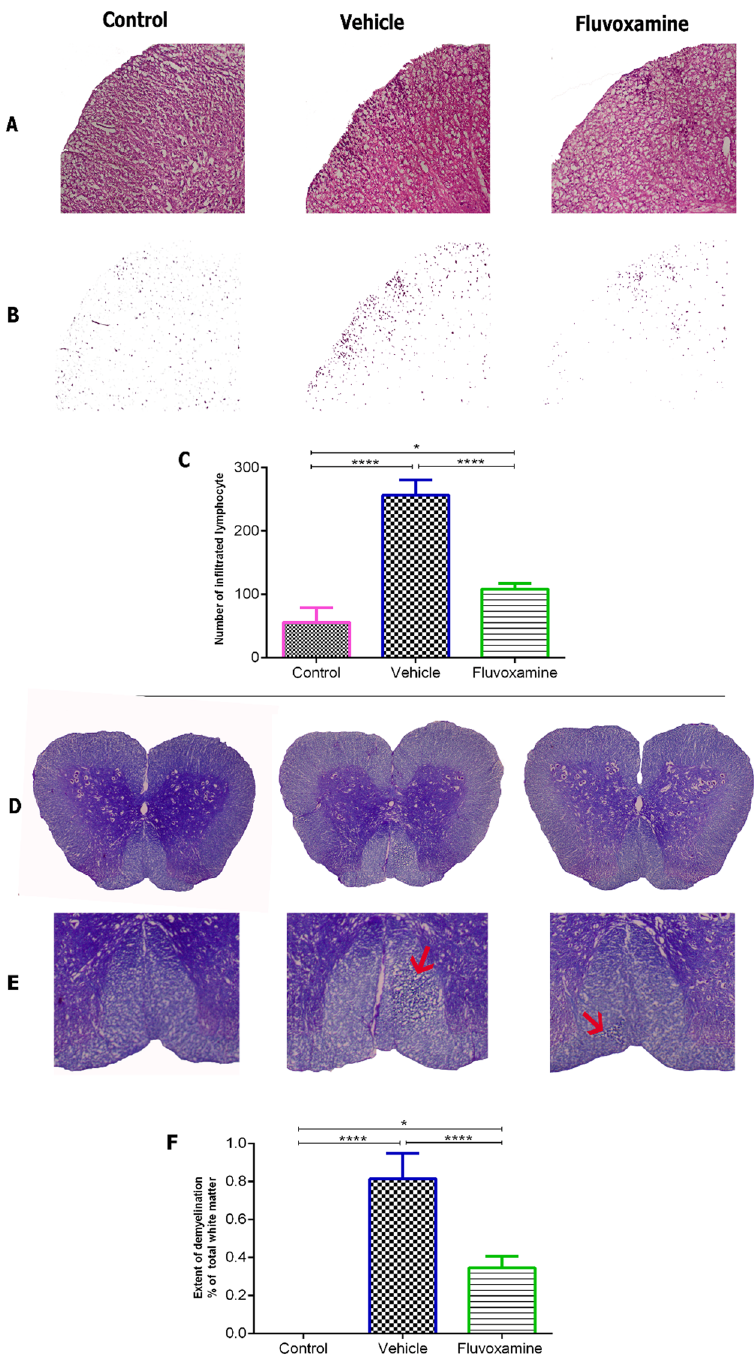
Figure 8. Fluvoxamine treatment enhanced histological outcomes in spinal cords of EAE rats. In order to detect inflammatory infiltration and demyelination, serial sections were analyzed by Hematoxylin and Eosin ( A – C ) and Luxol Fast Blue staining ( D – F ). ( A ) Inflammatory infiltration with extensive perivascular cuffing was limited and decreased in fluvoxamine treated EAE rats, in comparison to EAE control rats. ( B ) Infiltrated cells are shown without background tissue, a modification from panel (A). ( C ) Infiltration of immune cells was significantly reduced in fluvoxamine group, compared to vehicle ( **** p < 0.0001). ( D , E ) Red arrows indicates demyelination area which is reduced in fluvoxamine group, compared to EAE vehicle rats. ( F ) Quantitative analysis for percent of demyelination area of total white matter using Luxol Fast Blue staining. Fluvoxamine induced a reduction in demyelination area (0.81%), compared to vehicle (0.34%). Data are expressed as mean ± SEM from seven rats per